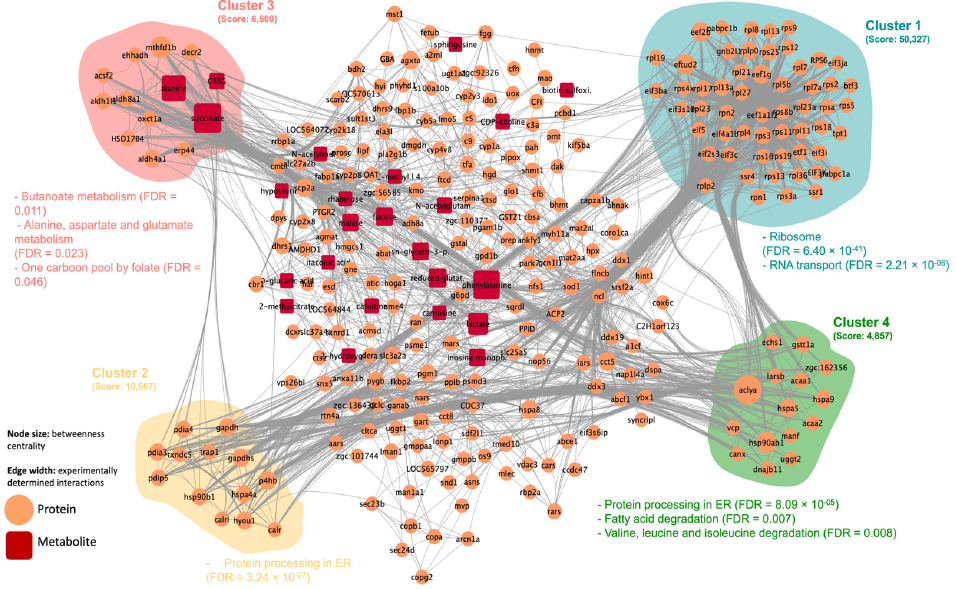
Figure 3. Metabolic reaction network generated with the differential abundant proteins and metabolites identified in the liver of gilthead seabream subjected to a net-handling challenge. Node shape and color represent the type of biomolecule, according to the legend. Edges represent functional linkages between them. The highlighted clusters, depicted with the MCODE plugin within Cytoscape software, represent the most interconnected regions, with the corresponding overrepresented in KEGG terms (FDR < 0.05).